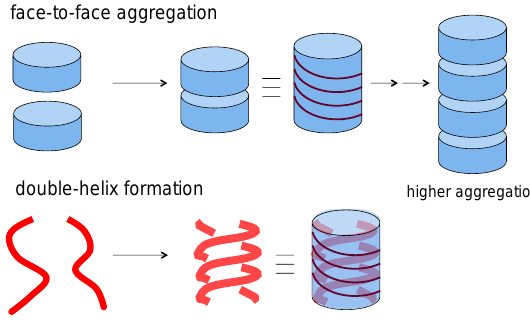
Figure 4. Methods of synthesis of cylindrical structures by molecular complexation.